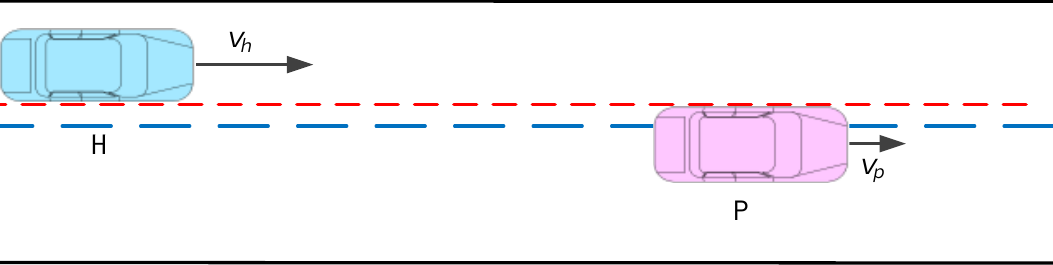
Figure 6. Vehicle’s body Figure 6. Vehicle ’s body overlap.